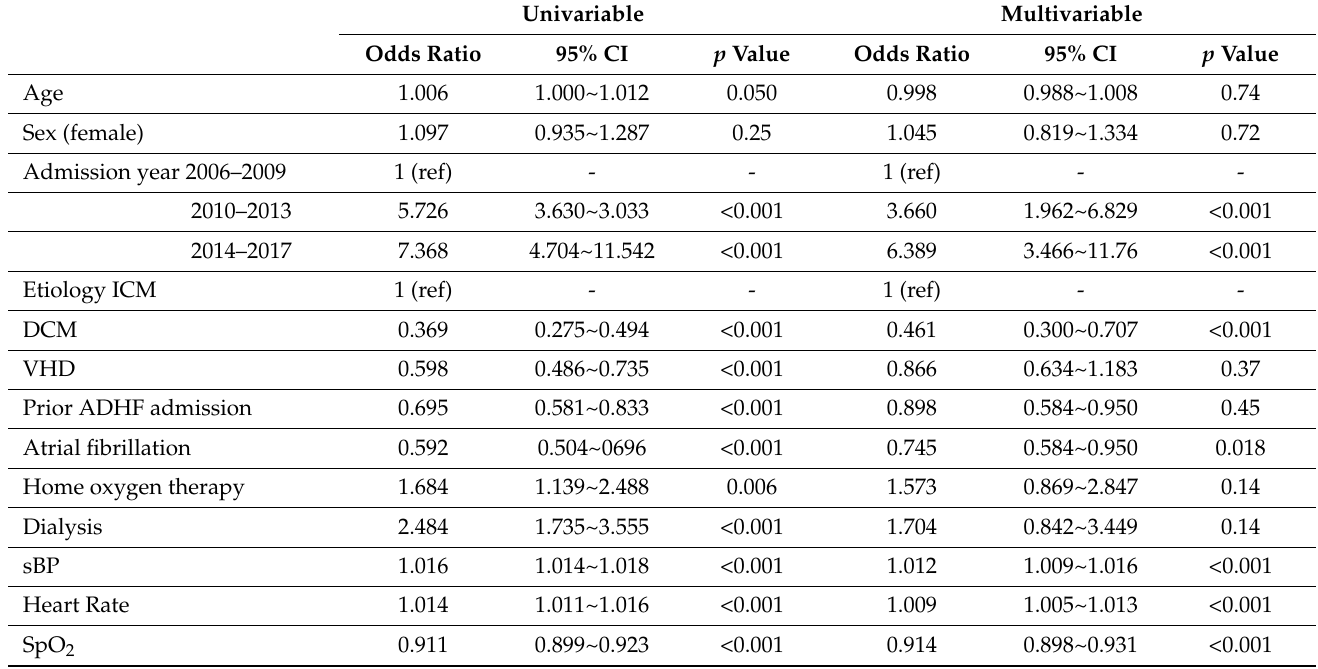
Table 1. Univariable and multivariable logistic regression for non-invasive positive pressure ventilation Use.